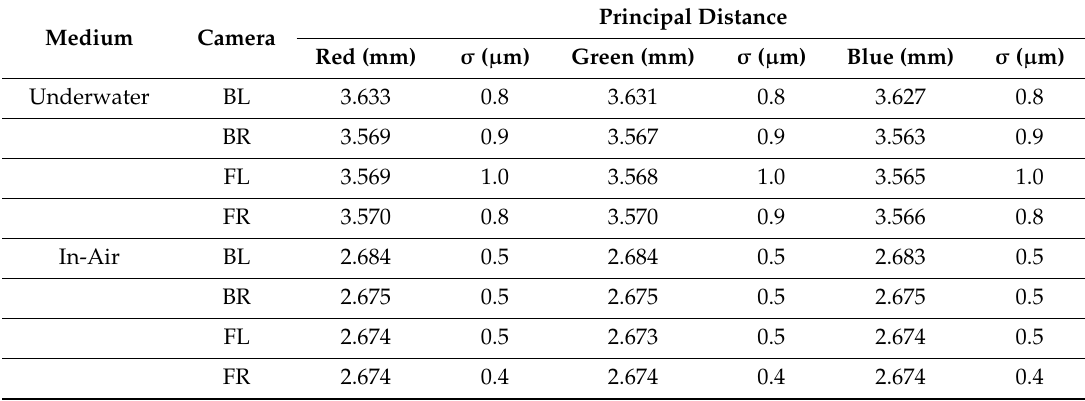
Table 5. Principal distances and their standard deviations from the CMB adjustments.